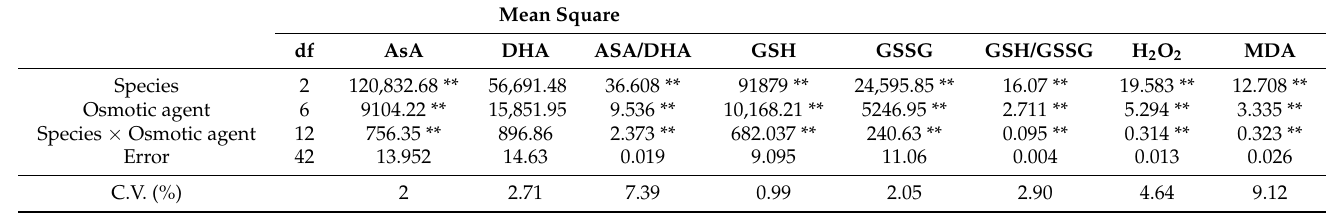
Table 5. The ANOVA analysis of the effects of PEG and mannitol on biochemical and non-enzymes activity in Cucurbita sp. genotypes under in vitro conditions.